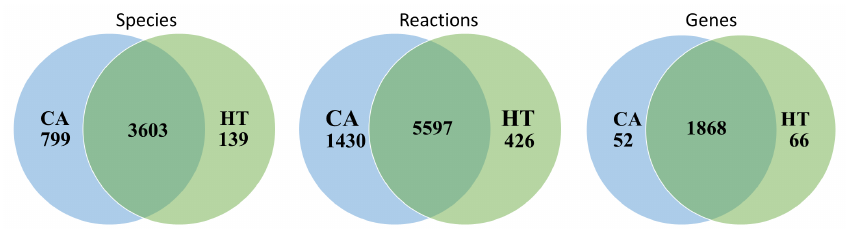
Figure 3. Comparison of metabolic network data between HT and CA models. Statistics of cancer (CA) and healthy (HT) reconstructed metabolic models. The basal (BL) model is the union set of the CA and HT models.